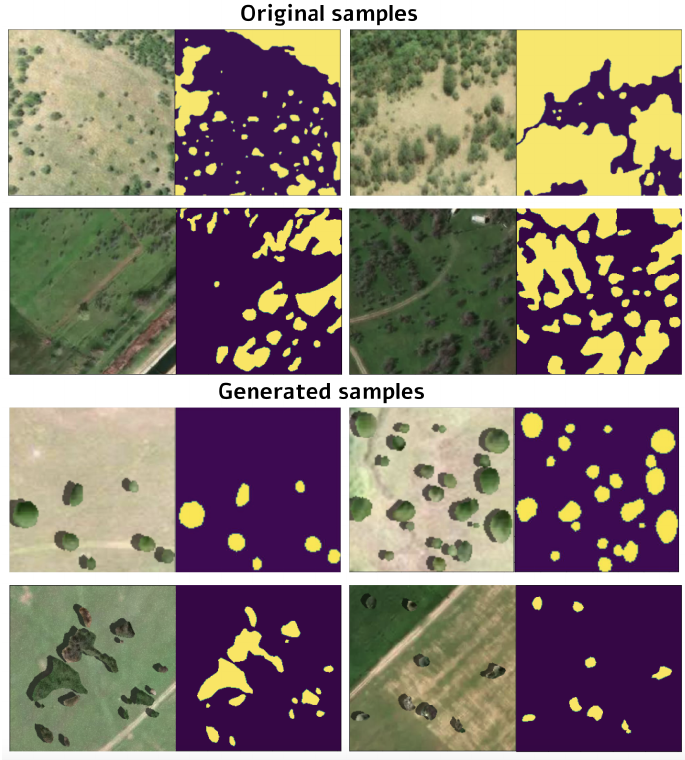
Figure 2. Examples of original and generated samples and tree masks. In the generated samples, new various backgrounds were used to achieve greater diversity and to combine trees’ images and masks from different areas. Artificially added shadows provide more realistic images associated with semantic segmentation